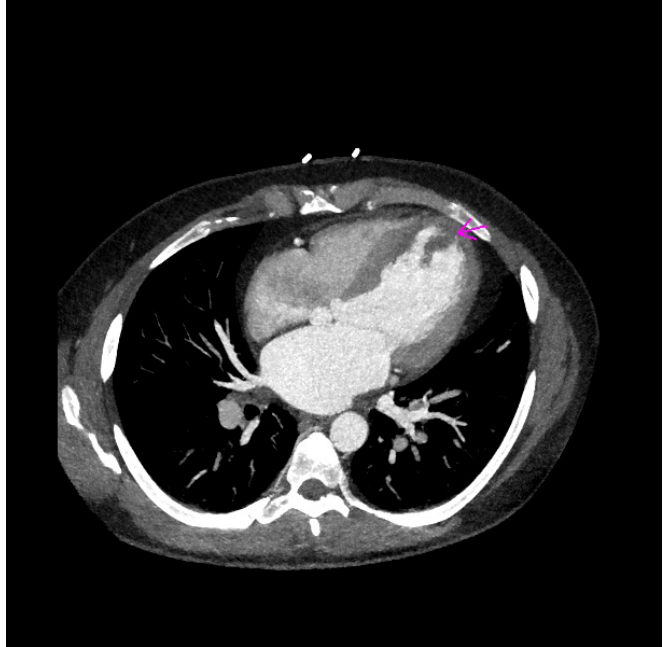
Figure 4. CT finding of first thrombus in the area of left ventricular apex (purple arrow).